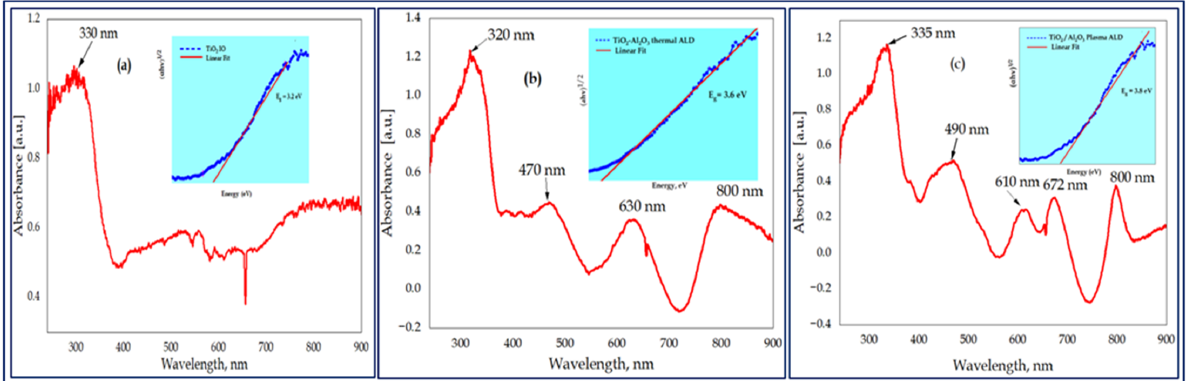
Figure 5. A linear fit to the straight part of the h ν vs ( α h ν ) 1/2 plot (Tauc plot) intercepts the energy axis at the optical band gap energy: the indirect energy band gap for TiO 2 IO ( a ), Al 2 O 3 /TiO 2 thermal ALD, and ( b ) Al 2 O 3 /TiO 2 plasma ALD ( c ).